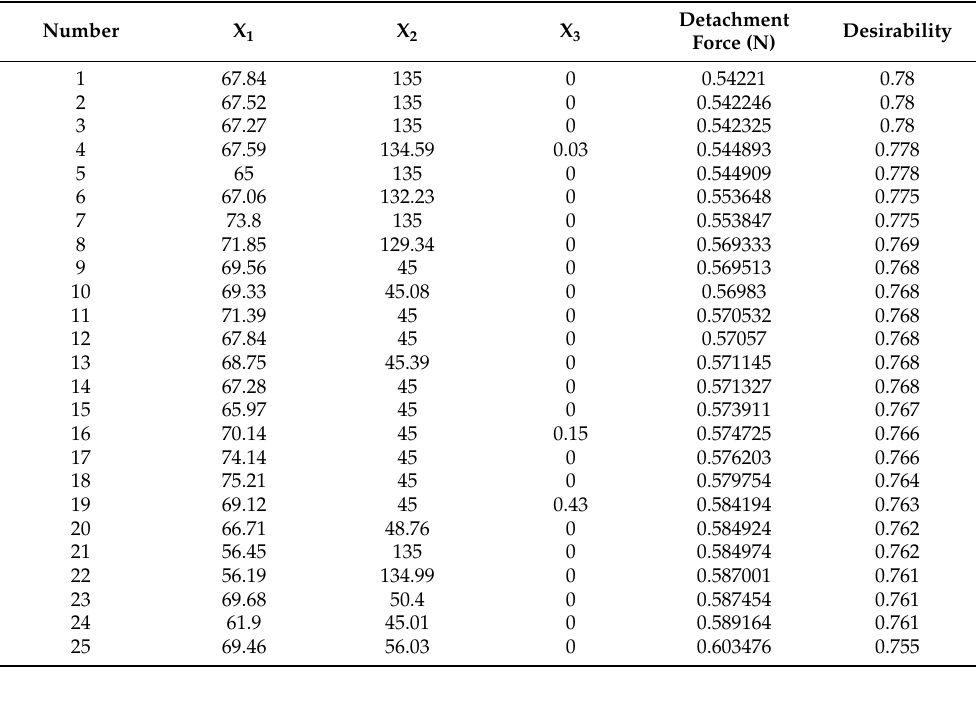
Table 6. Optimal combination for detachment force for higher desirability.